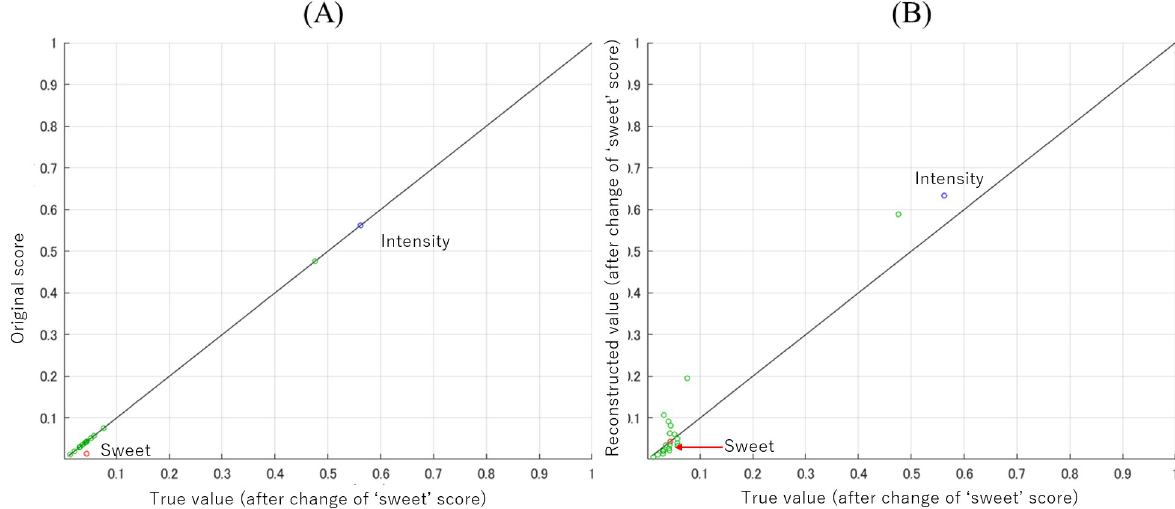
Fig 11. Predicted sensory test score (A) : The score for the original apple flavor (vertical axis) and the true value with the score of ‘sweet’ was multiplied by 3.0 (horizontal axis). (B) : The score for the explored mass spectral feature (vertical axis) and the true value with the score of ‘sweet’ was multiplied by 3.0 (horizontal axis). The blue, red and green plots are those of ‘intensity’, ‘sweet’ and others, respectively.